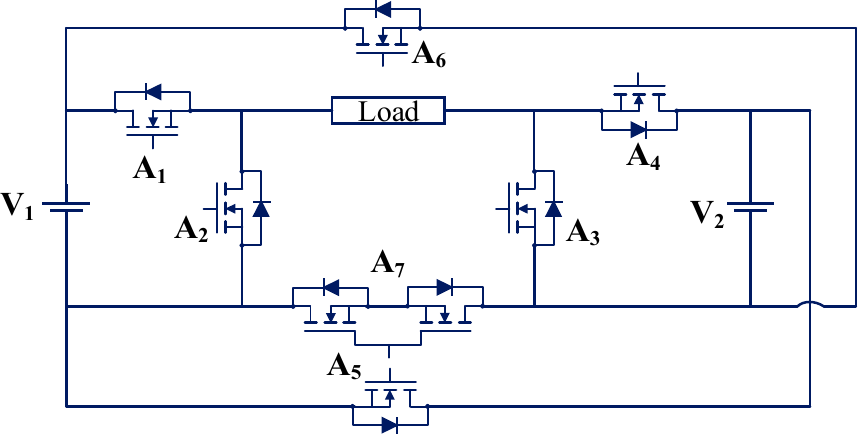
Figure 39. Single-phase five-level FT MLI (TP42) [74].